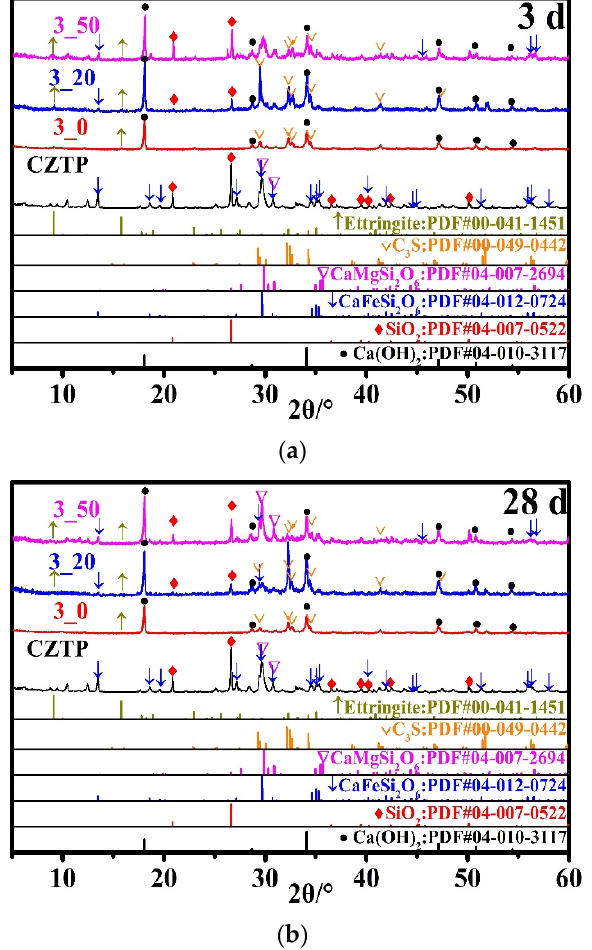
Figure 8. XRD patterns of samples cured for ( a ) 3 d and ( b ) 28